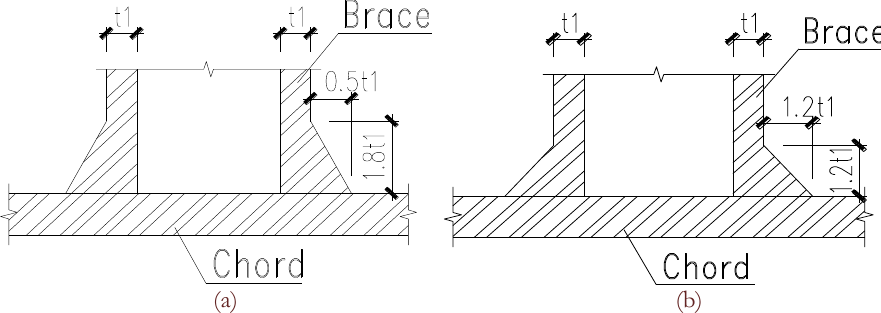
Figure 10: Recommended weld sizes in finite-element